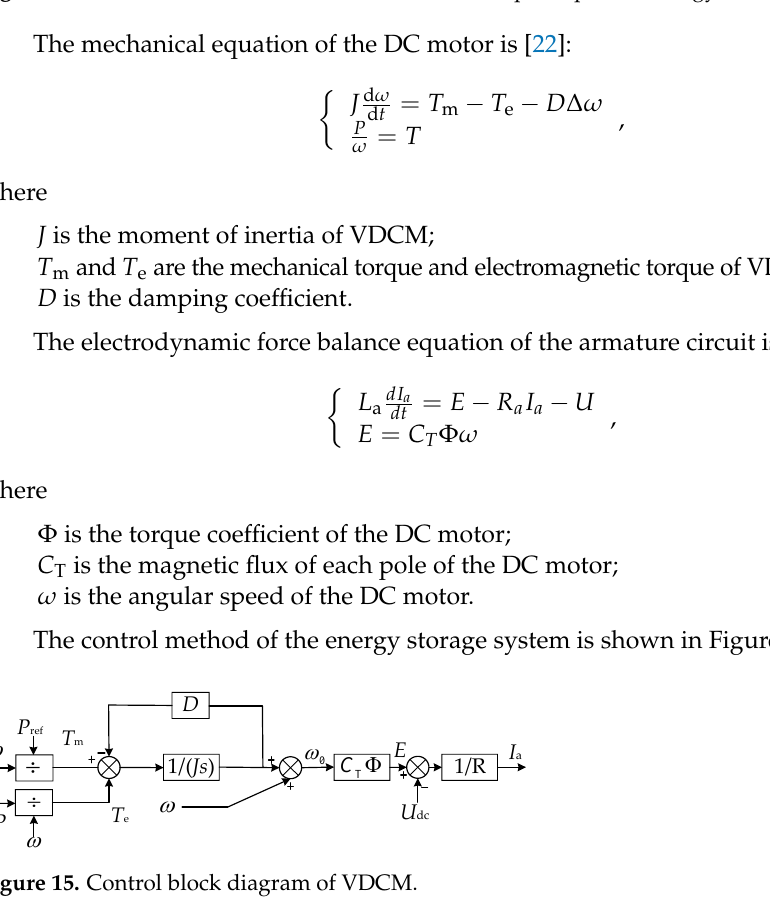
Figure 14. MMC-RPC scheme based on distributed super capacitor energy storage.